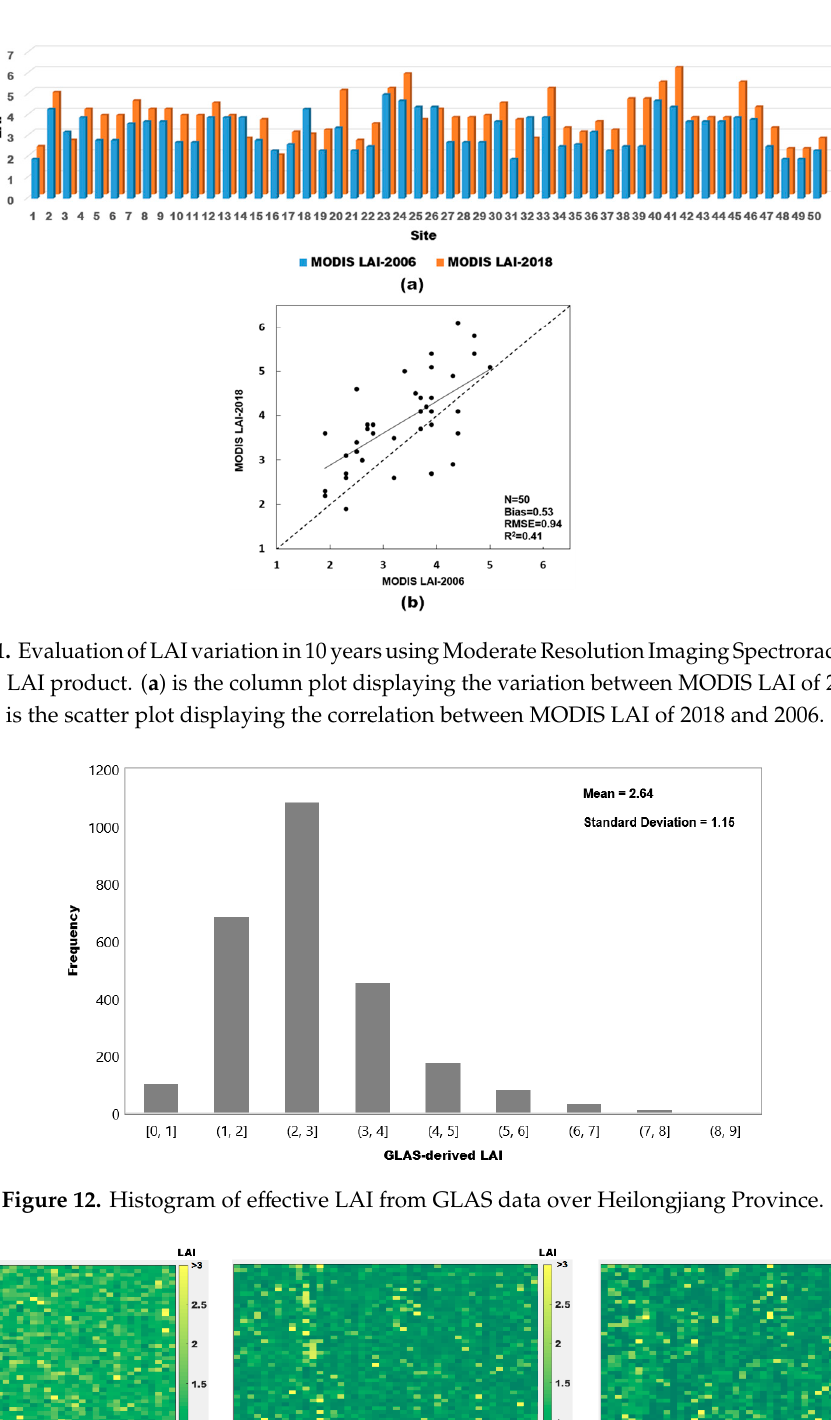
Figure 12. Histogram of effective LAI from GLAS data over Heilongjiang Province. Figure 13. Vertical LAI integration maps from 0 to 4 m, 4 to 8 m, 8 to 18 Figure 13. Vertical LAI integration maps from 0 to 4 m, 4 to 8 m, 8 to 18 m.